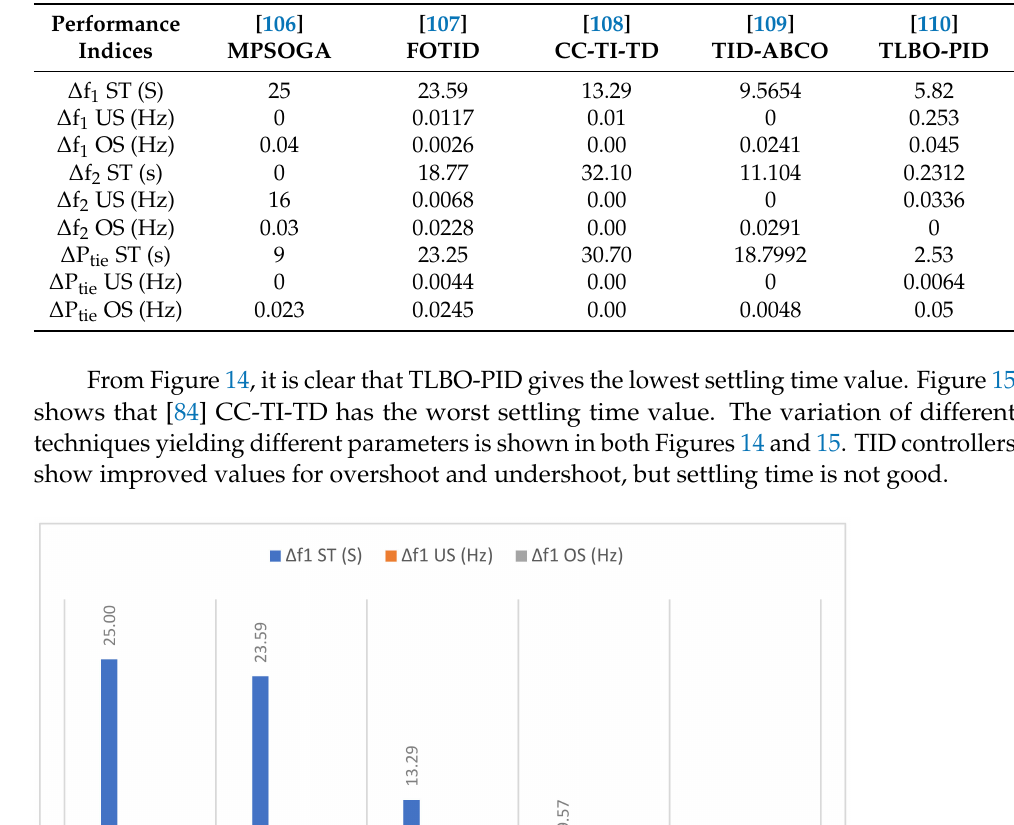
Table 6. Performance Indices of TID Controller in an Interconnected Power System.